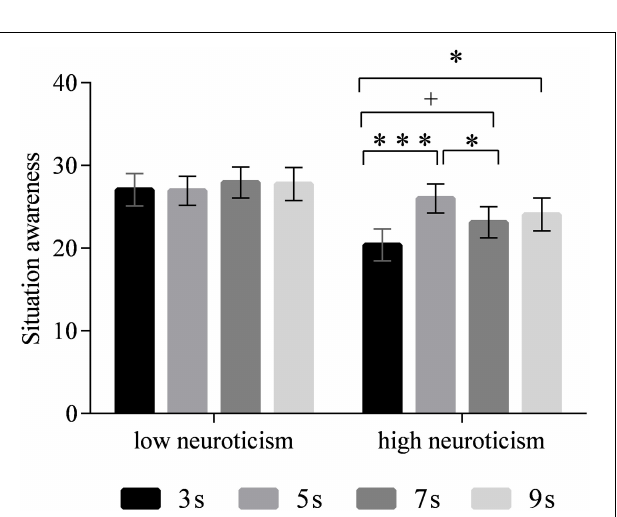
FIGURE 7 | Situation awareness of different time intervals for drivers with the low and high neuroticism. (Notes. 0.05 < + p < 0.1, * p < 0.05, *** p <